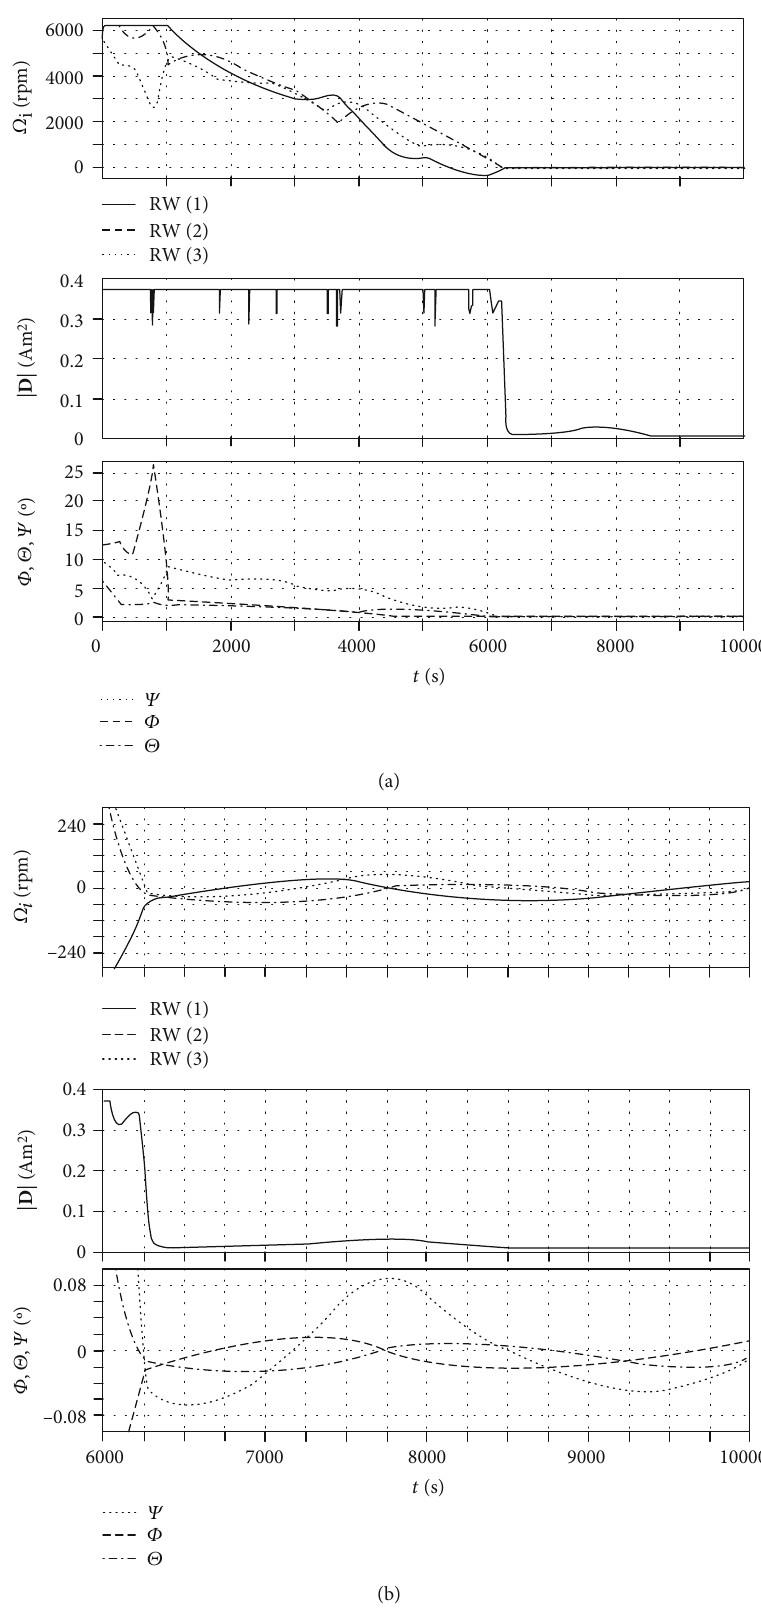
Figure 11: (a) Momentum unloading mode, reaction wheels in orthogonal con fi guration. (b)